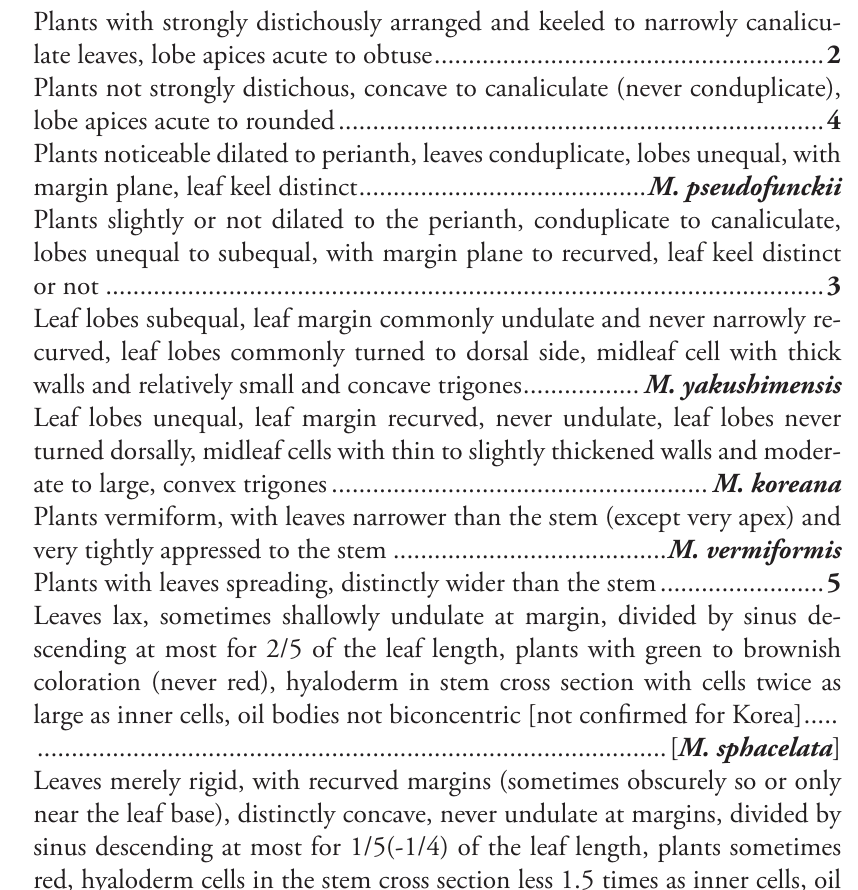
Leaves lax, sometimes shallowly undulate at margin, divided by sinus de- scending at most for 2/5 of the leaf length, plants with green to brownish coloration (never red), hyaloderm in stem cross section with cells twice as large as inner cells, oil bodies not biconcentric [not confirmed for Korea] ..... – Leaves merely rigid, with recurved margins (sometimes obscurely so or only near the leaf base), distinctly concave, never undulate at margins, divided by sinus descending at most for 1/5(-1/4) of the leaf length, plants sometimes red, hyaloderm cells in the stem cross section less 1.5 times as inner cells, oil bodies biconcentric or not .......................................................................... 6 Oil bodies without central eye or with very small eye, plants’ color varying in exposed places to brown and rusty, but never red and purple .... M. apertifolia Oil bodies always or at least in 50% of oil bodies with central eye, plants